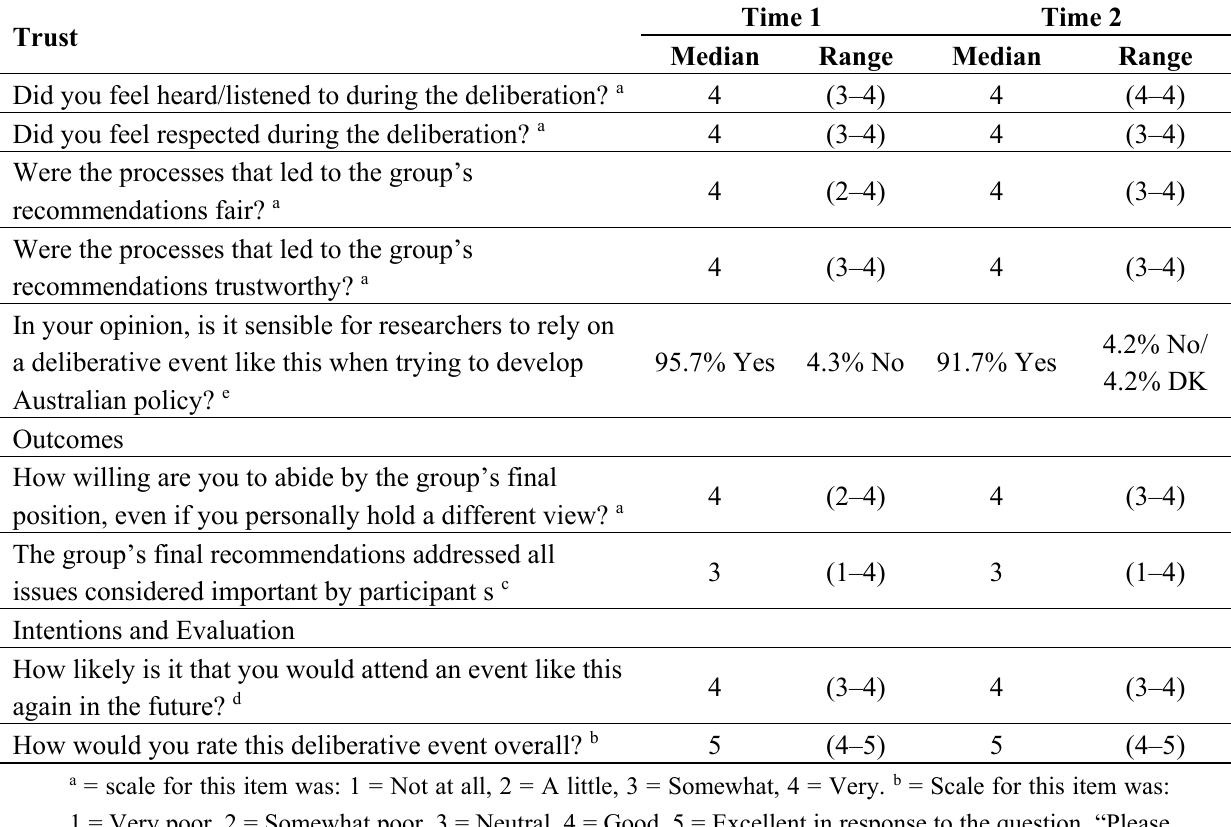
Table 2. Descriptive statistics for the participant satisfaction survey at Time 1 and Time